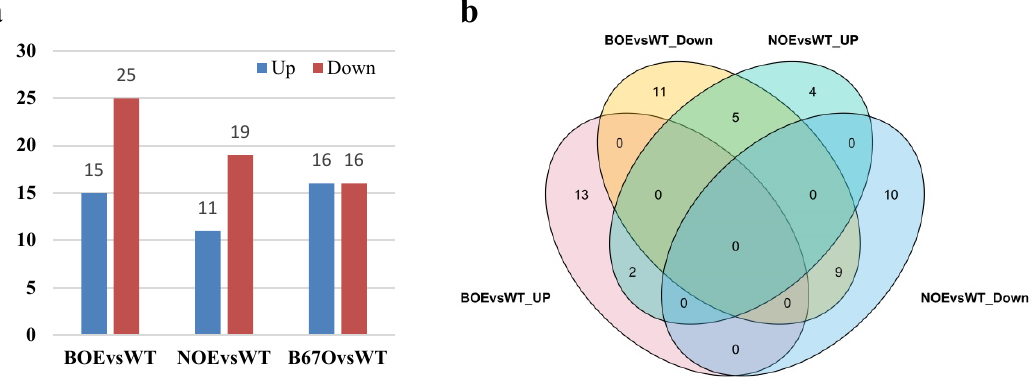
Figure 9. The numbers of BnLTP family DEGs in transgenic rapeseeds (Westar cultivar) overexpressing pBAN::BnTT1 (BOE, 20 DAP seeds, seed coat-specific promoter), pNapA::BnTT1 (NOE, 20 DAP seeds, seed embryo-specific promoter) and pNapA::BnbZIP67 (B67O, 25 DAP seeds, seed embryo-specific promoter) ( a ); Venn diagram of the numbers of BnLTP family DEGs in BOE and NOE ( b ).